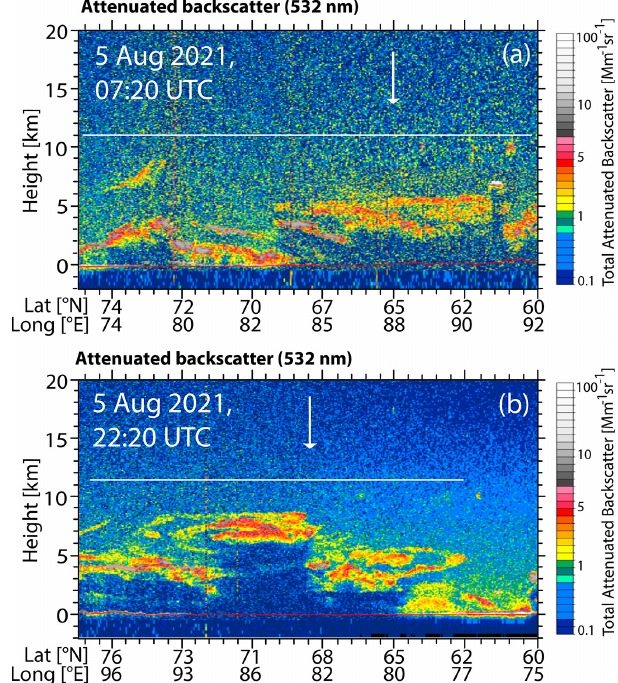
Figure 16. CALIOP measurement of 532nm attenuated aerosol backscatter caused by thick wildfire smoke in the troposphere over central northern Siberia (a) on 5 August 2021 at 07:20 UTC (early afternoon over central Siberia) and (b) on 5 August 2021 at 22:20 UTC (early morning). Horizontal lines indicate the tropopause. The vertical white arrow in (a) shows the starting point of the HYSPLIT forward trajectory and the white arrow in (b) the end point of the forward trajectory (downwind) after